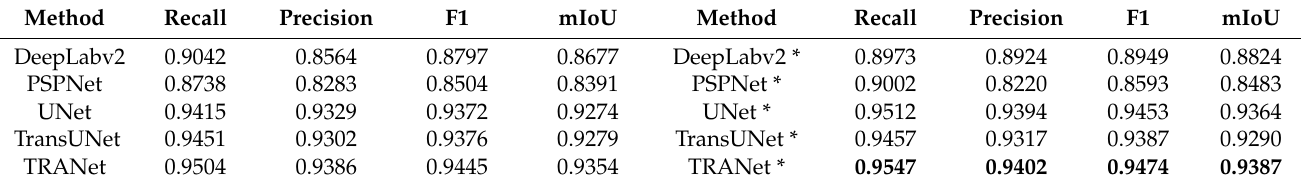
Table 8. Building extraction accuracies with different discriminator networks. The highest accuracy is displayed in bold.